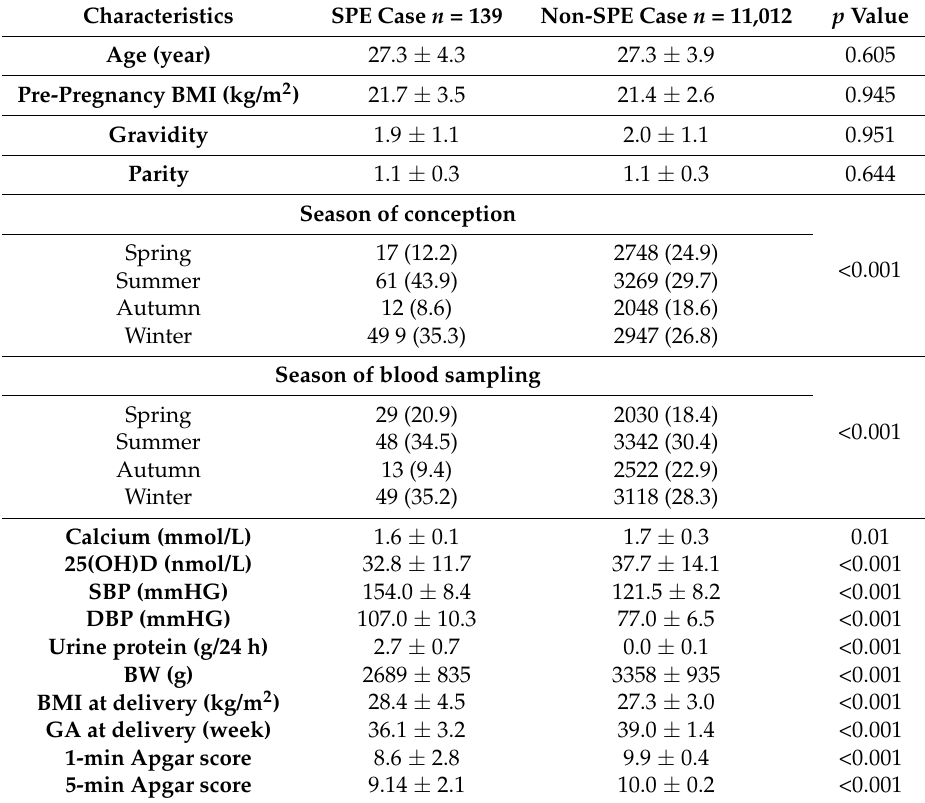
Table 3. Demographic and clinical characteristics of pregnant women with severe preeclampsia and those